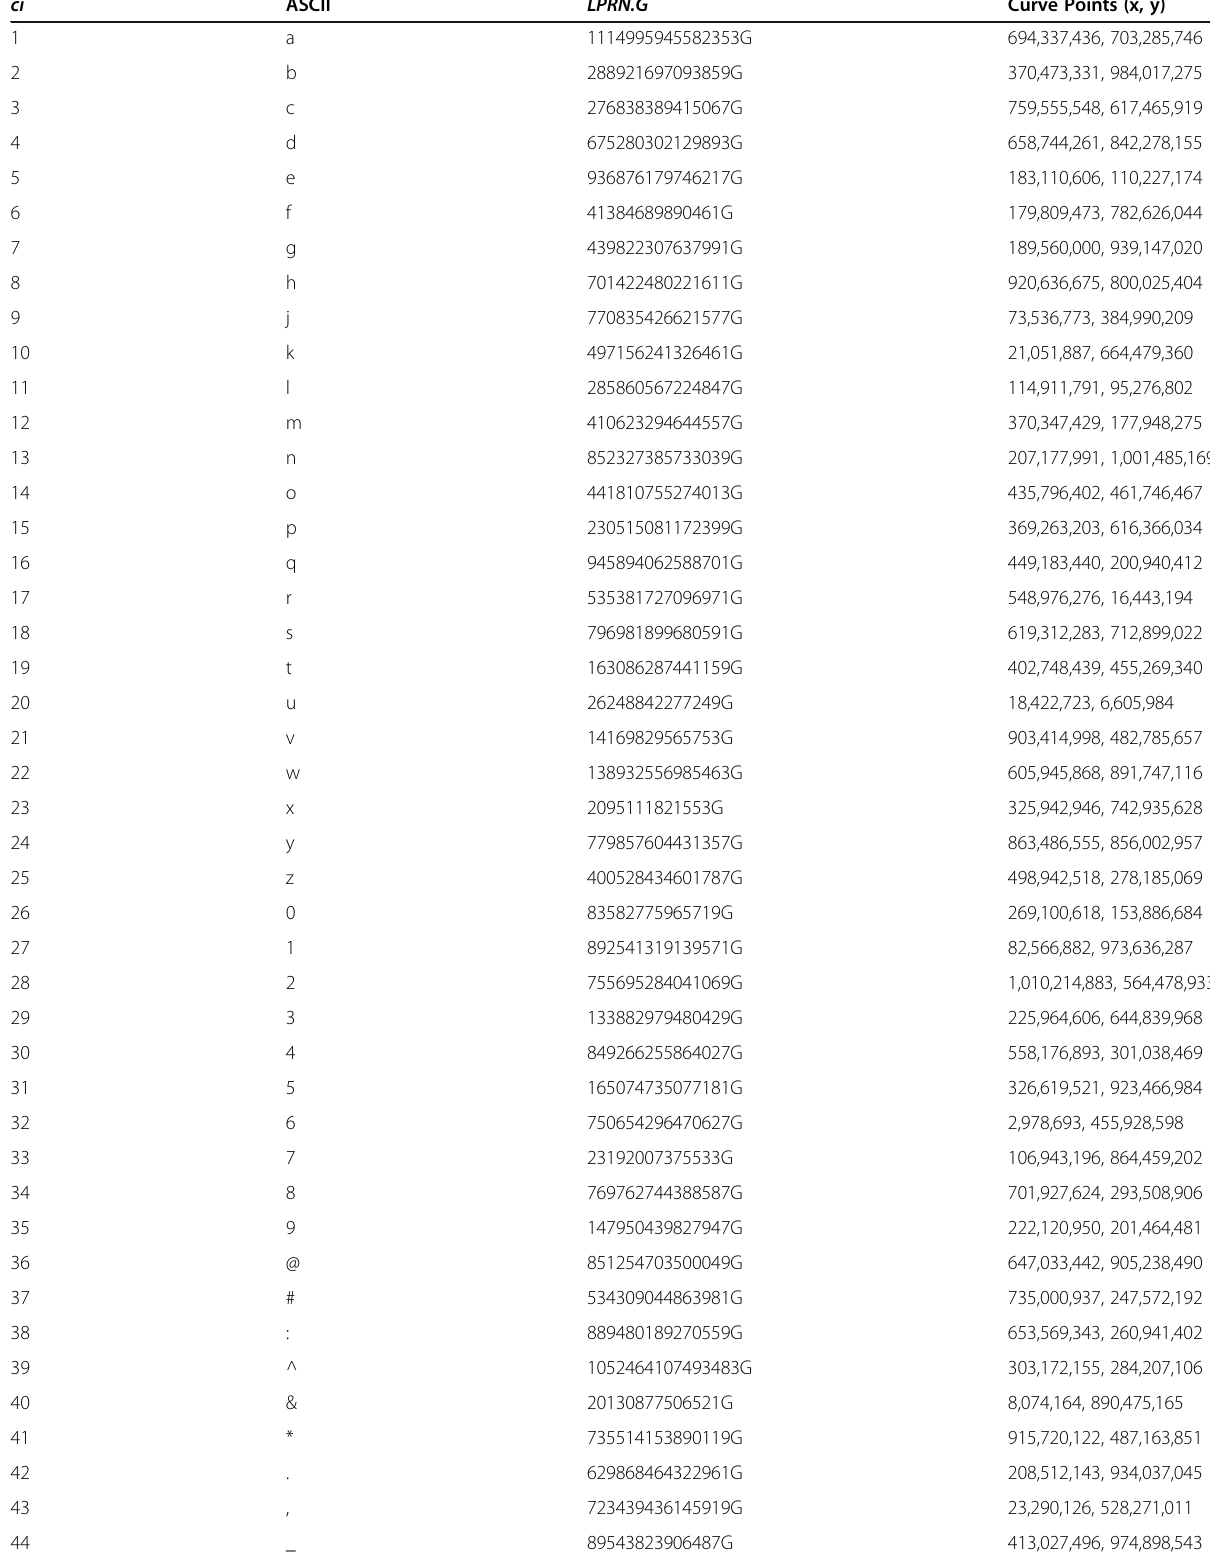
Table 2 Reference table in proposed hash